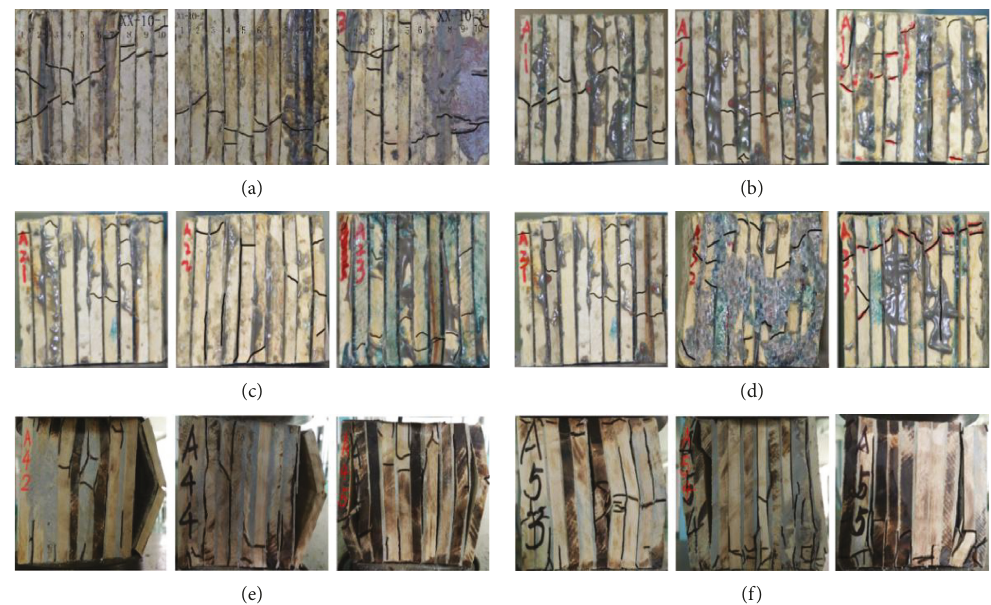
Figure 5: Failure mode of the specimens X 1 and A 1-5: (a) X 1, (b) A 1, (c) A 2, (d) A 3, (e) A 4, and (f) A